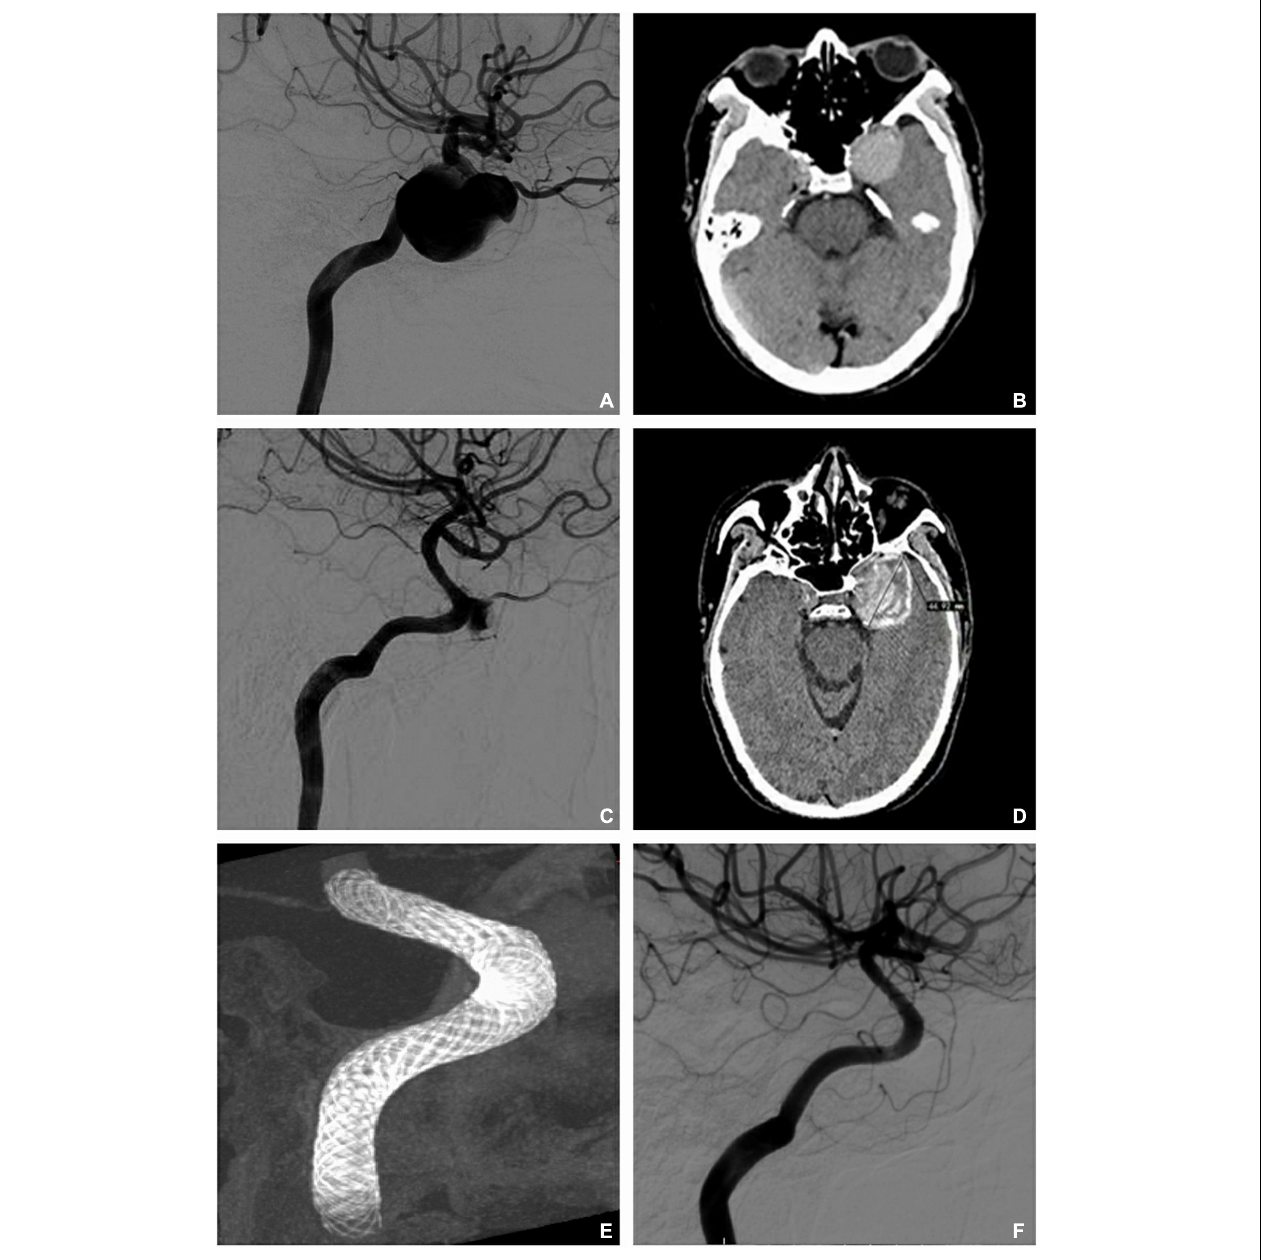
FIGURE 3 | Retreatment for unoccluded aneurysms (telescope and overlap techniques). (A) Digital subtraction artery (DSA) identified a giant aneurysm with a proximal diameter of 4.33 mm and a distal diameter of 3.93 mm in the internal carotid artery before operation. (B) Computed tomography (CT) revealed the maximum diameter of the aneurysm as 32 mm before operation. (C) DSA showed no occlusion after the implantation of two telescoped pipeline embolization devices (PEDs; 4.75 × 35 mm/4.75 × 30 mm) for 36 months. (D) CT shows that the sac enlarged over 36 months (maximum diameter = 45 mm). (E) Vaso-CT demonstrates the reconstruction after another two PEDs (4.5 mm × 30 mm/4.5 mm × 20 mm) overlapped at the neck of the aneurysm. (F) Complete occlusion is seen at 10 months after retreatment with the two overlapping